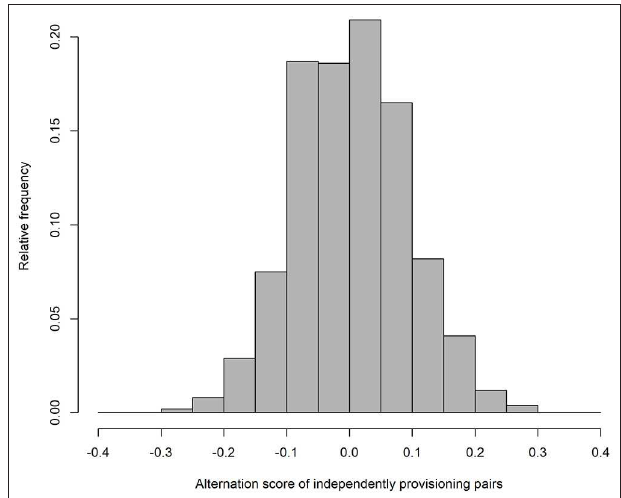
FIGURE 1 | The frequency distribution of alternation scores from simulated provisioning sequences ( n = 1,000) when parents provision independently.